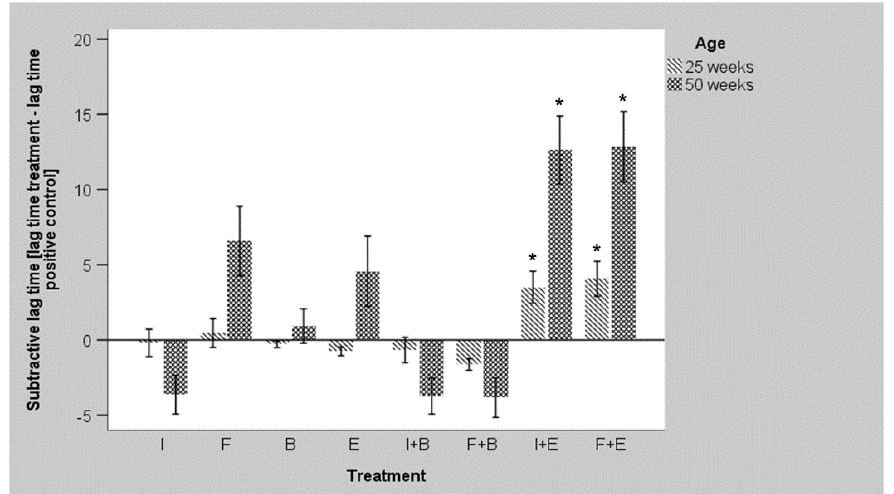
Figure 3. Comparison of different treatments and ages regarding the lag time [h] of E. coli O1/O18 (I = Inulin, F = FOS, E = Enterococcus faecium , B = Bacillus coagulans , + = combination; mean values, n = 15 for each age, all farms included, error bars indicate the SEM, significant differences compared to positive control are indicated by